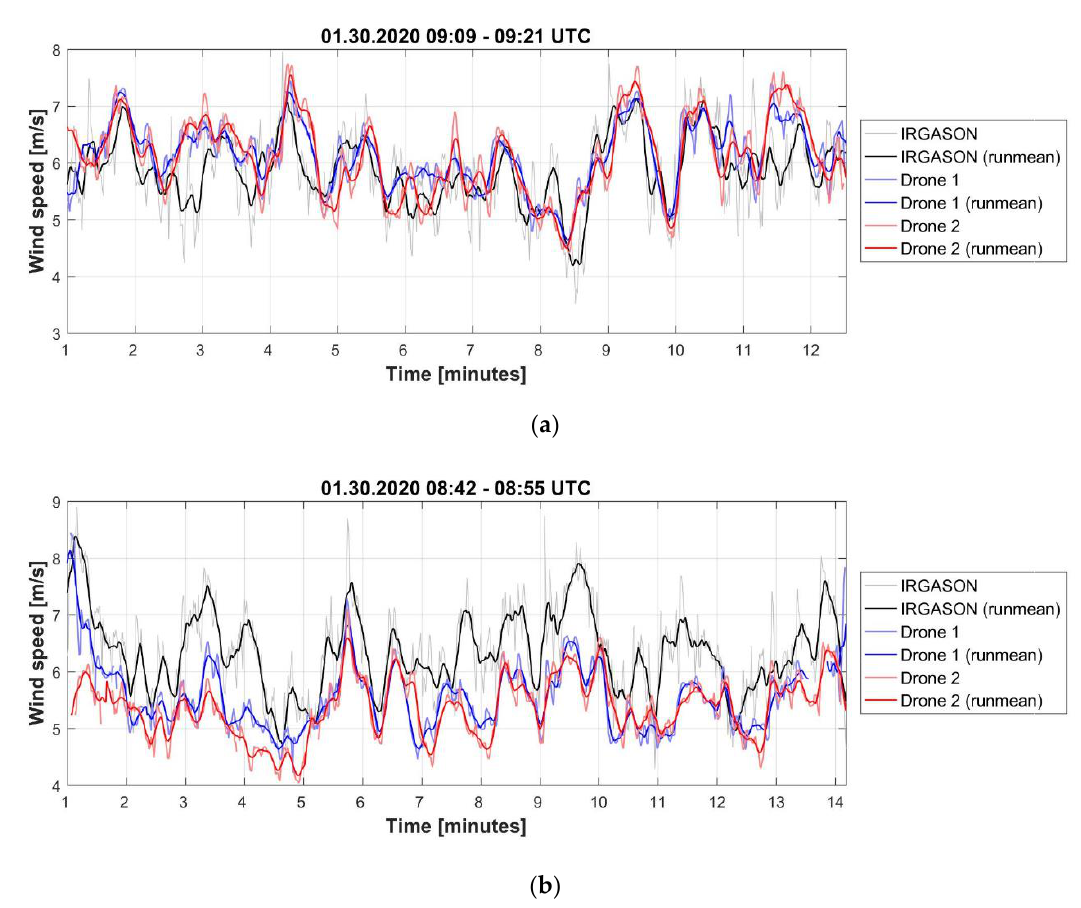
Figure 3. Comparison of the wind speed series, measured by IGRASON anemometer and estimated by the drones during hovering near anemometer, for cases when the drones were headed perpendicular the airflow ( a ) and along the airflow ( b ). Data are shown with 1 Hz frequency and after applying a running mean with 10 s window.